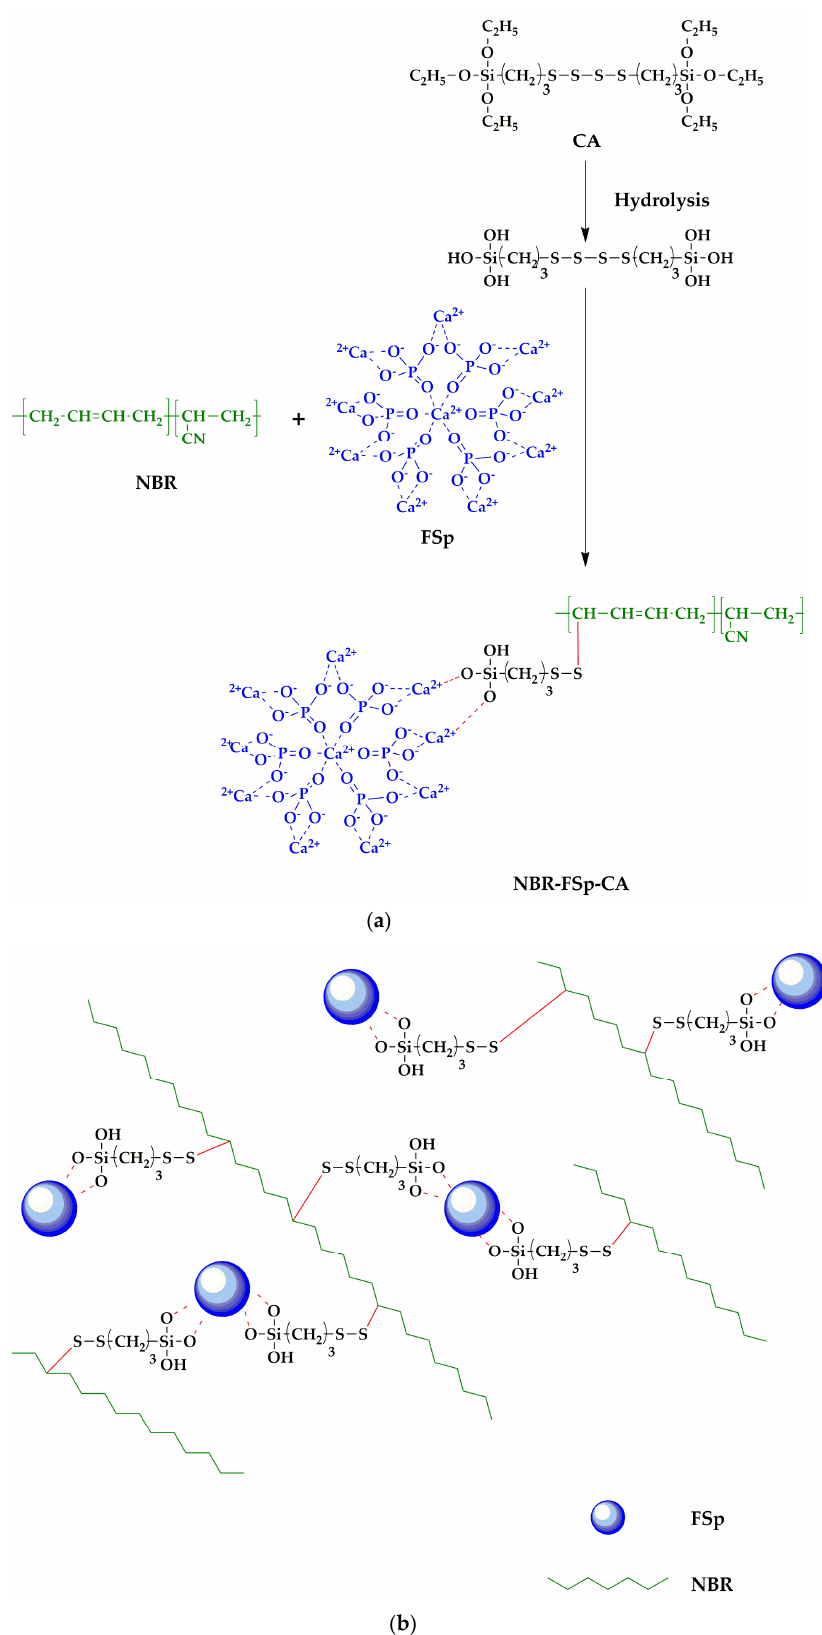
Figure 7. ( a ) Schematic representation of NBR/FSp/CA interactions and ( b ) Sketch of the interface interaction between FSp, CA, and NBR chains. interaction between FSp, CA, and NBR